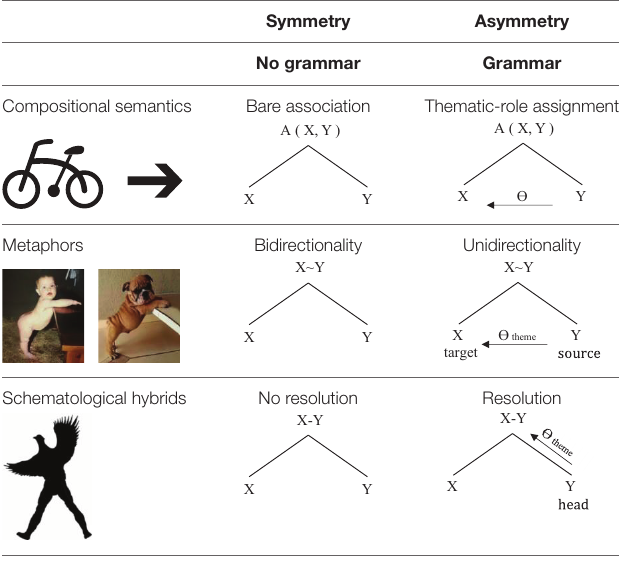
TABLE 1 | Symmetry and asymmetry in compositional semantics, metaphors and schematological